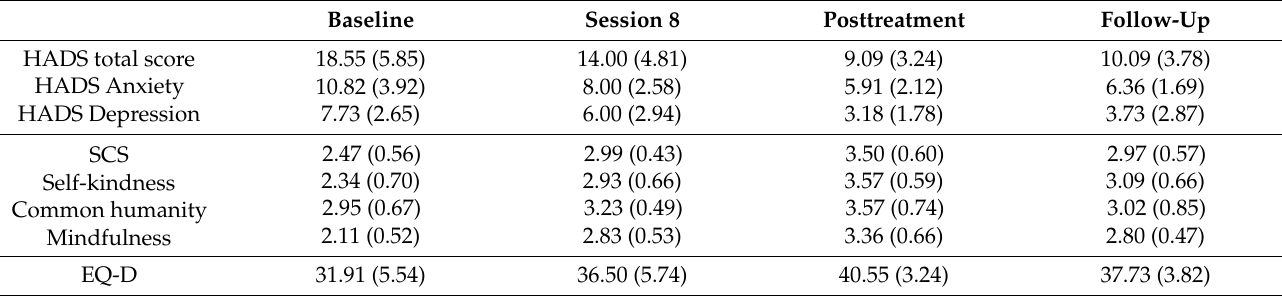
Table 1. Means and standard deviations (SD) of the study outcomes at each assessment point. Baseline